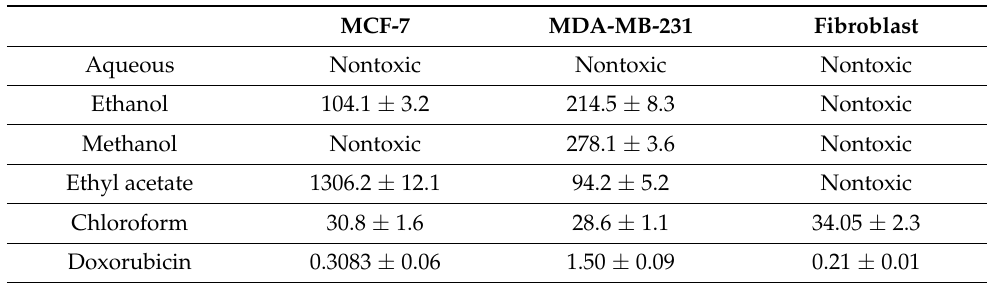
Figure 3. Antiproliferative effect of L. angustifolia extracts on ( A ) MCF-7 cells and ( B ) MDA-MB cells. Data are described as mean ± SD, n = 3. Table 4. IC 50 ( µ g/mL) for different extracts of L. angustifolia tested on three cell lines (MCF7, MDA- MB-231, and